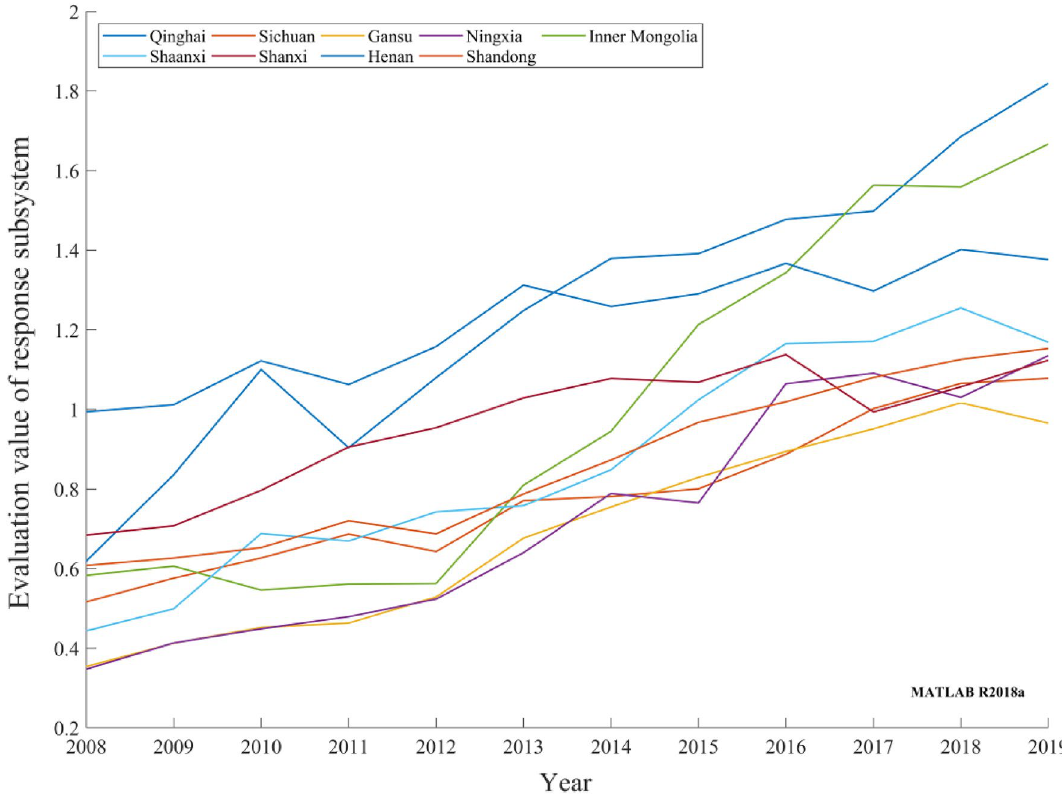
Figure 7. Evaluation values of provincial carbon-neutral response subsystems in the Yellow River basin during 2008–2019.